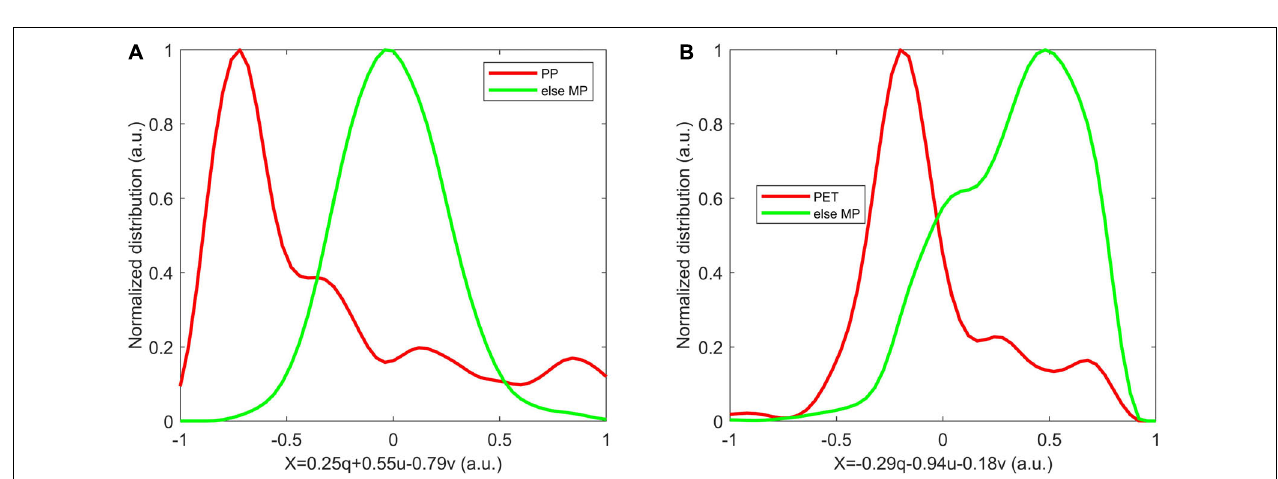
FIGURE 9 | (A) Prymnesium Parvum (PP) and other five types of microplastics (MPs). (B) Polyethylene Eerephthalate (PET) and other five types of